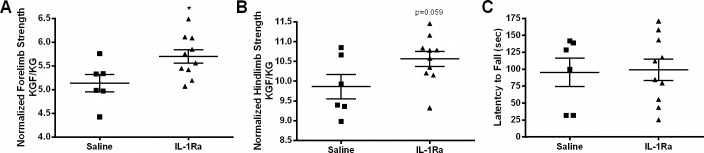
Grip strength is increased in mdx mice treated with IL-1Ra.Maximal strength (KGF) was measured using a grip-strength meter and normalized to body mass in kg to determine the force per kg of animal mass (KGF/KG). Animals treated with IL-1Ra (n = 10) had significantly higher (A) maximal (p = 0.047, 11% increase) and (C) normalized forelimb grip-strength (p = 0.028, 11% increase) than did control saline-treated (n = 6) animals. Hindlimb strength was measured in the same way as forelimb, and there was an increase in (B) maximal hindlimb grip strength (p = 0.100, 7% increase) and (D) normalized hindlimb strength when the means of the IL-1Ra treated (10.56 KGF/KG) and saline-injected mice (9.87 KGF/KG) were compared; this difference almost reached statistical significance (p = 0.058). There were also no significant differences in hindlimb grip strength without normalization, although a similar trend remained. (E) There were no significant differences in the latency to fall in control- (95.44s) and IL-1Ra- (99.15s) treated mdx mice, although the mean values showed a longer latency to fall for the IL-1Ra-treated mice. Values in the graphs represent mean ± SEM. Statistically significant differences were determined by parametric, unpaired, two-tailed, t-tests with a p≤0.05 being significant.